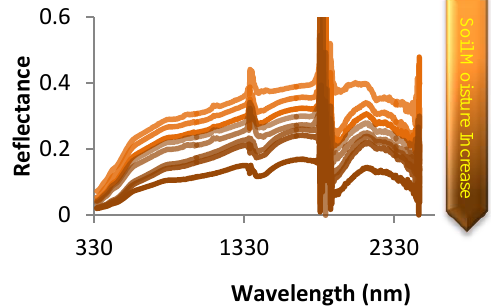
Fig. 1 Spectral Reflectance curve of Soil (that is measured with ASD